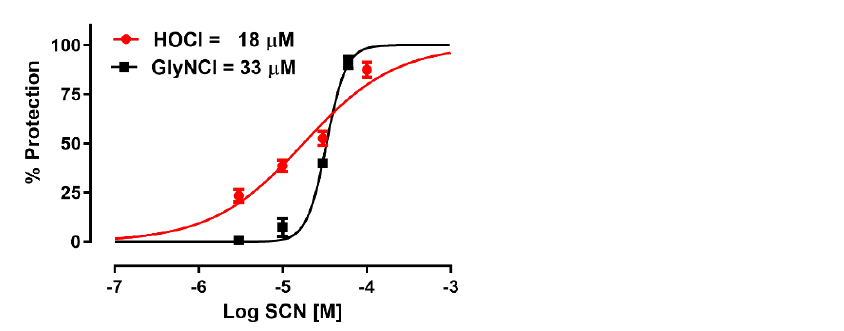
Figure 10. Thiocyanate (SCN) protects human bronchial epithelial cells from hypochorous acid (HOCl) and glycine chloramine (glyNCl)-induced injury . Human bronchial epithelial cells (16HBE41o-) were treated for 30 min with either glycine chloramine (200 µ M, GlyNCl) or with HOCl (200 µ M) for 60 min in PBS, then placed back in media. Cell viability was assessed 24 h later using a MTT assay. The 50% protective -SCN concentrations (EC50) were determined by non-linear regression. SCN had an EC50 of 18 and 33 M for HOCl and GlyNCl, respectively.